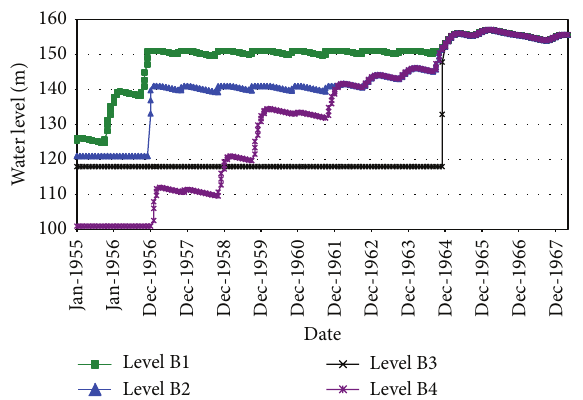
Figure 19: Water level variations during the flood